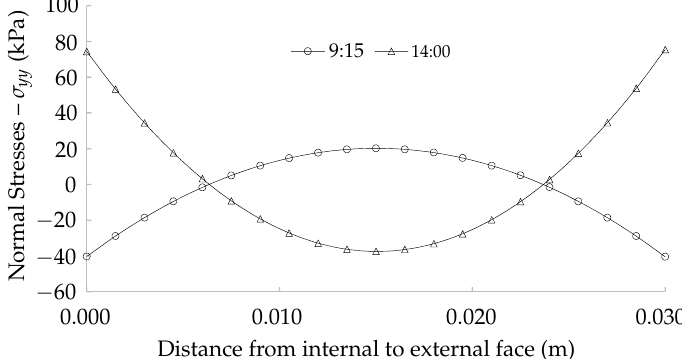
Figure 5. Thermal stresses calculated at 09:15 and at 14:00 on 10